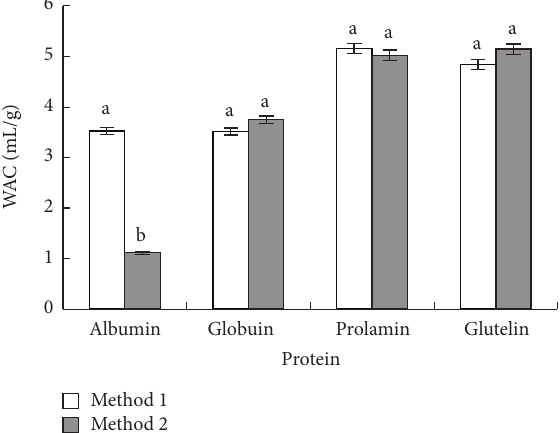
Figure 6: WAC of FRBPs prepared by the two extraction